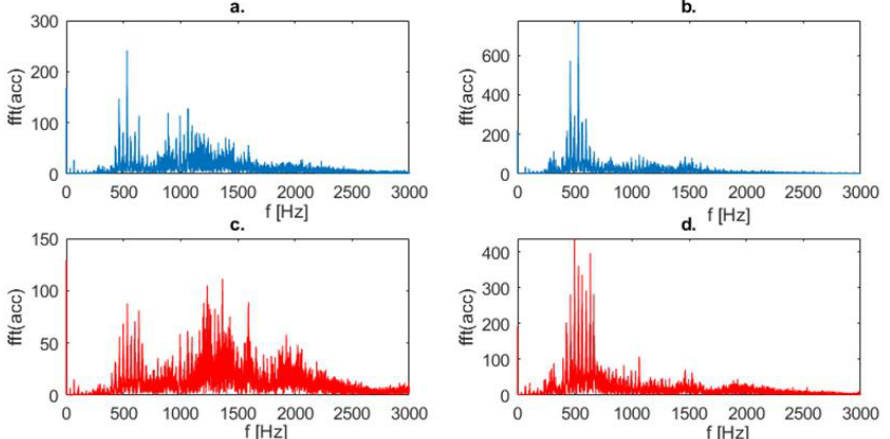
Figure 9. Frequency spectrum of vibration acceleration signal: ( a ) Vertical vibrations for fault-free state, ( b ) Horizontal vibrations for fault-free state, ( c ) Vertical vibrations for faulty state, ( d ) Horizontal vibrations for faulty state.